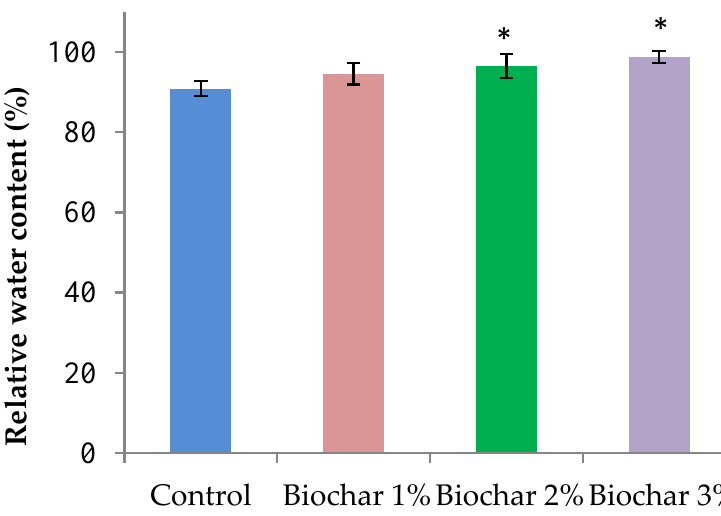
Figure 3. The impact of biochar concentrations on the relative water content of ginger. Data are means of three replicates ( n = 3), asterisks indicate significant differences from the control at p < 0.05. The data showed that the 2% biochar treatment significantly increased chlorophyll content by 23% compared to the control. The 3% biochar treatment showed a further increasing positive effect by 35% compared to the control (Figure 4).